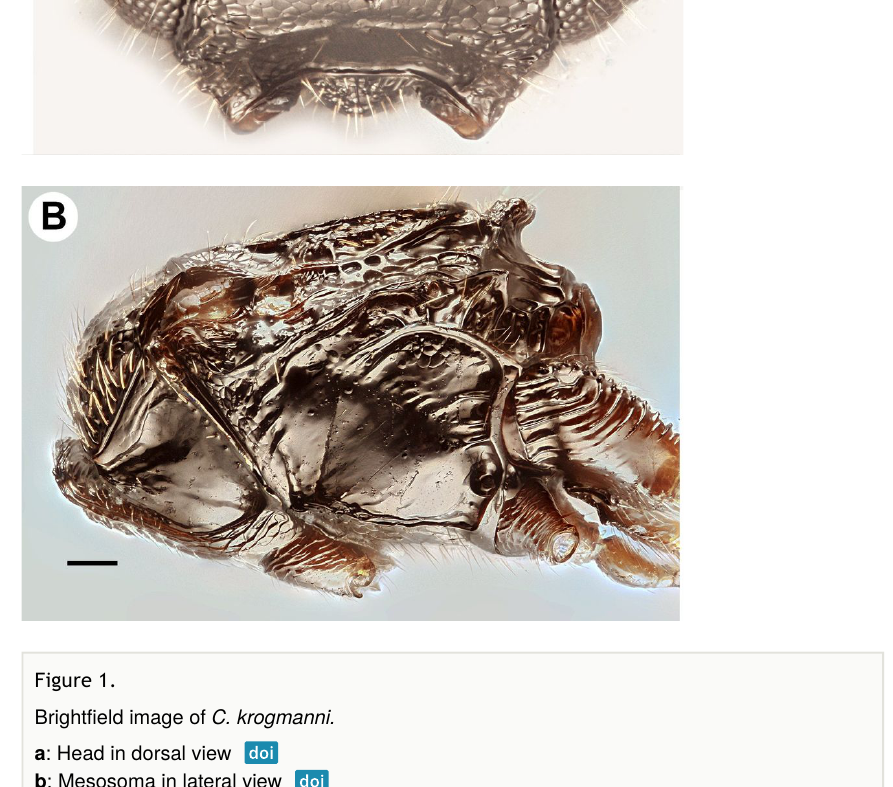
Bright fi eld image of C.